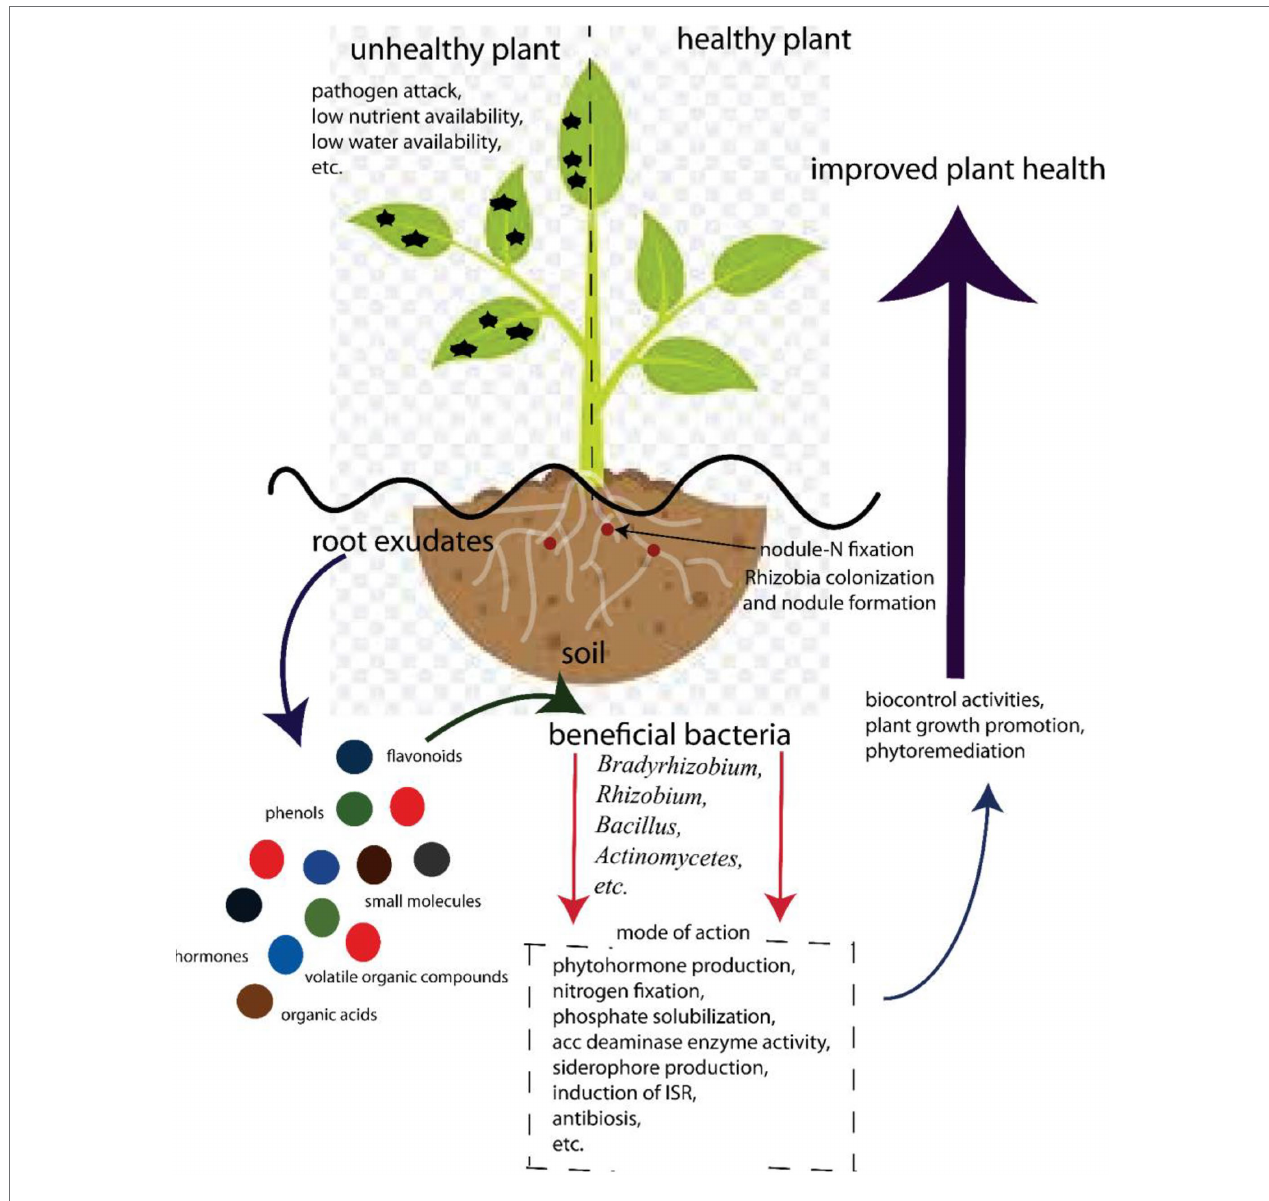
FIGURE 2 | Beneficial associations involved in Bambara groundnut–bacterial interaction for food